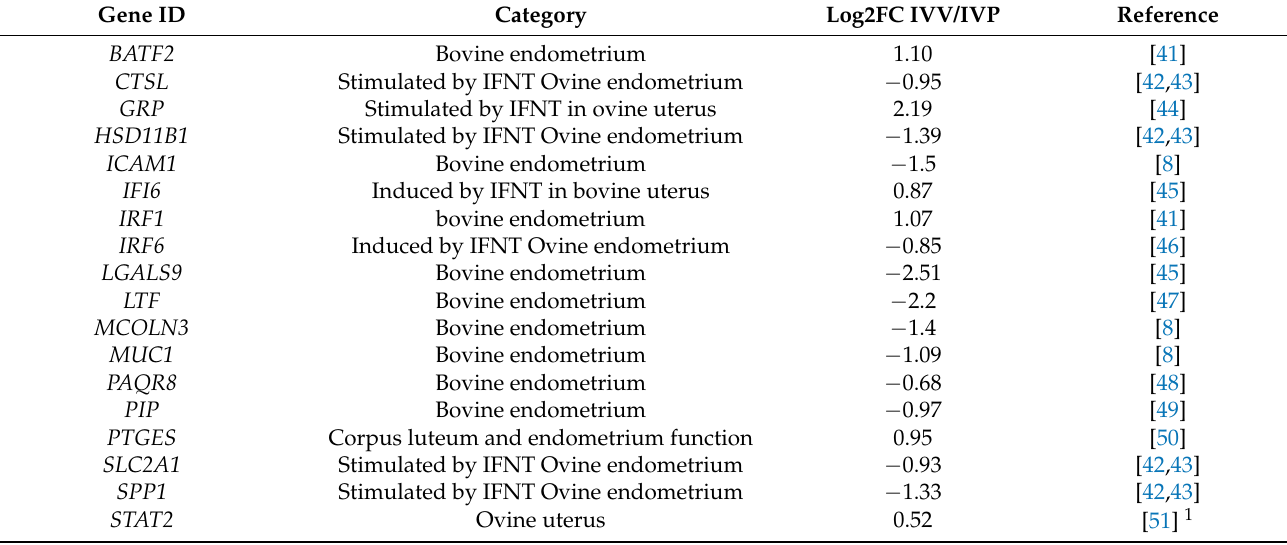
Table 3. Genes related to endometrial function and IFNT signaling with significant differences between EVs-IVV and EVs-IVP